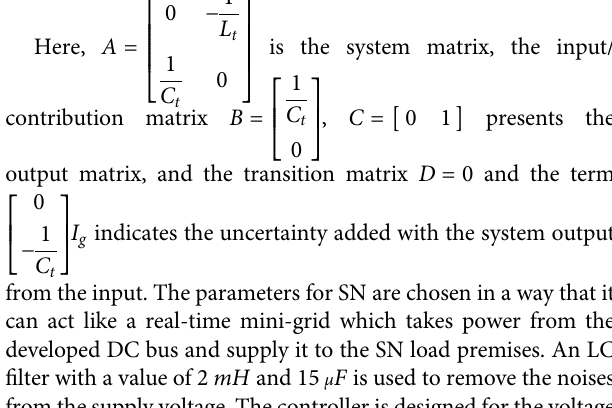
Frontiers in Energy Research |